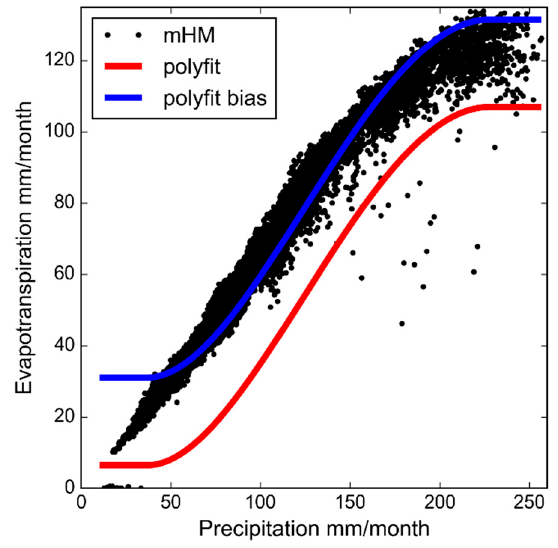
Figure 7. The spatial pattern evaluation of the balanced runs of Cal1 and Cal2 against the rainy- season ET climatology (panel ( a )) and the precipitation normalized climatology (panel ( b )). Metric values for SPAEF and its three components are presented. The boxplots show the median (black line), inter-quantile range (box) and 1st and 99th percentiles (whiskers).